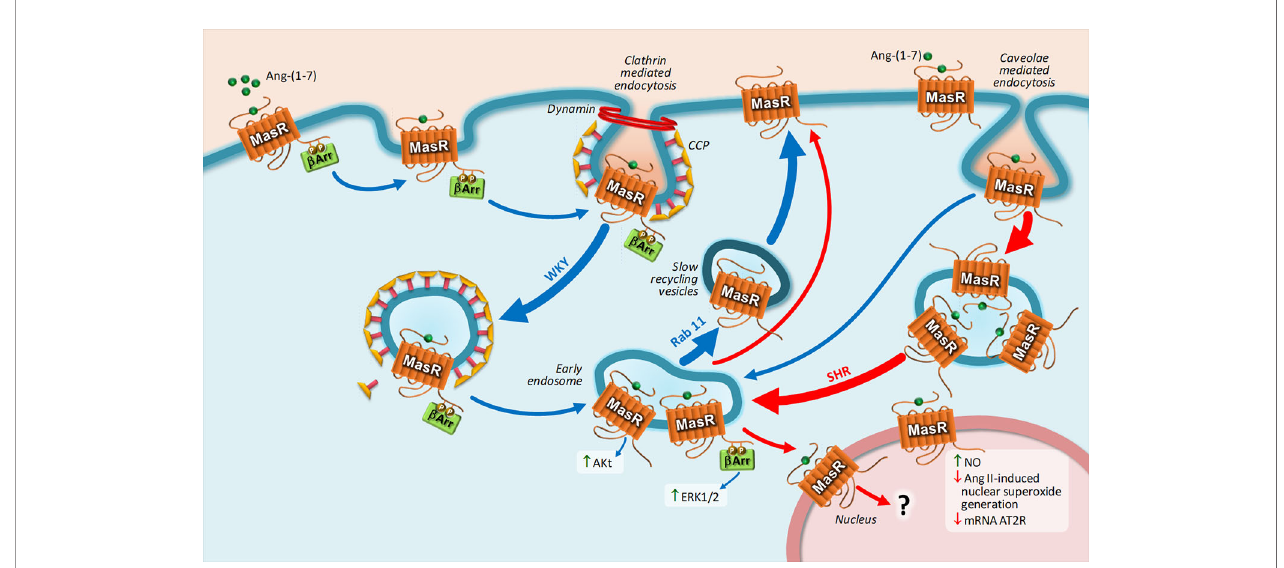
FIGURE 3 | Intracellular traf fi cking of MasR and main biological responses coupled to nuclear MasR stimulation. Upon Ang-(1-7) stimulation, MasR is endocyted into early endosome by CCPs and caveolae in a dynamin-dependent pathway and then recycled back to the cell surface by slow recycling vesicles. Once in early endosome, MasR triggers Akt and ERK1/2 activation. MasR undergoes a unique traf fi cking in brainstem neurons from SHR: the number of MasRs internalized through caveolae was greater compared to that internalized by CCPs and the number of receptors that were returned to the cell membrane was smaller, resulting in a lower amount of resensitized MasRs present at the plasma membrane. A fraction of MasRs is translocated to the nucleus bound to its ligand only in brainstem neurons obtained from SHRs and not from normotensive rats. Upon stimulation, constitutive nuclear MasR stimulates NO generation and opposes the increase in nuclear superoxide production and the decrease in AT2R mRNA expression induced by Ang II. Blue and red arrows represent MasR traf fi cking in brainstem neurons Wistar-Kyoto (WKY) and spontaneously hypertensive rats (SHR), respectively. Abbreviations: Ang-(1-7), Angiotensin-(1-7); Ang II, Angiotensin II; AT2R, Ang II receptor type 2; ERK1/2, extracellular signal-regulated kinase 1/2; NO, nitric oxide; SHR, spontaneously hypertensive rat; WKY, Wistar Kyoto; b -arr, b -arrestin.